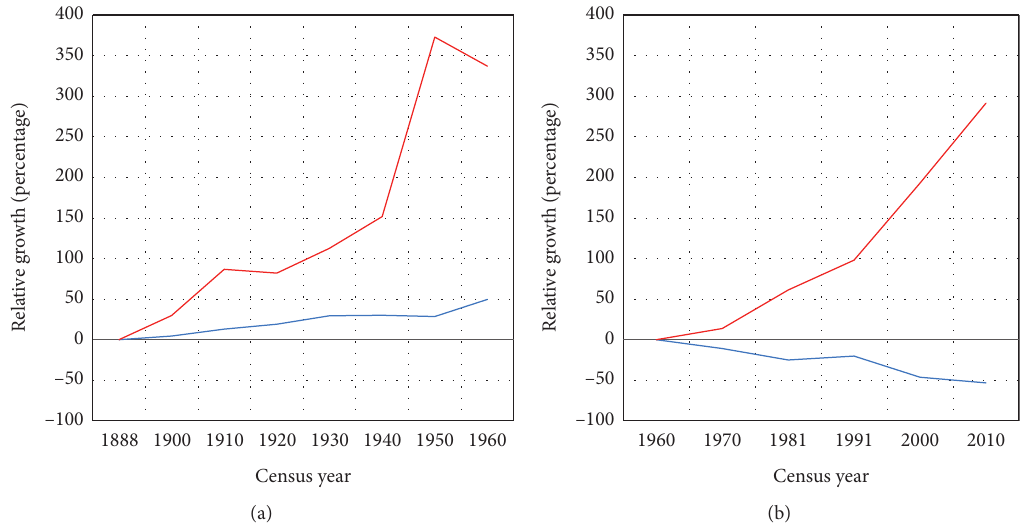
Figure 6: Relative growth of the capital town (red line) in comparison to the rest of the municipality excluding the capital town (blue line) before and after 1960.